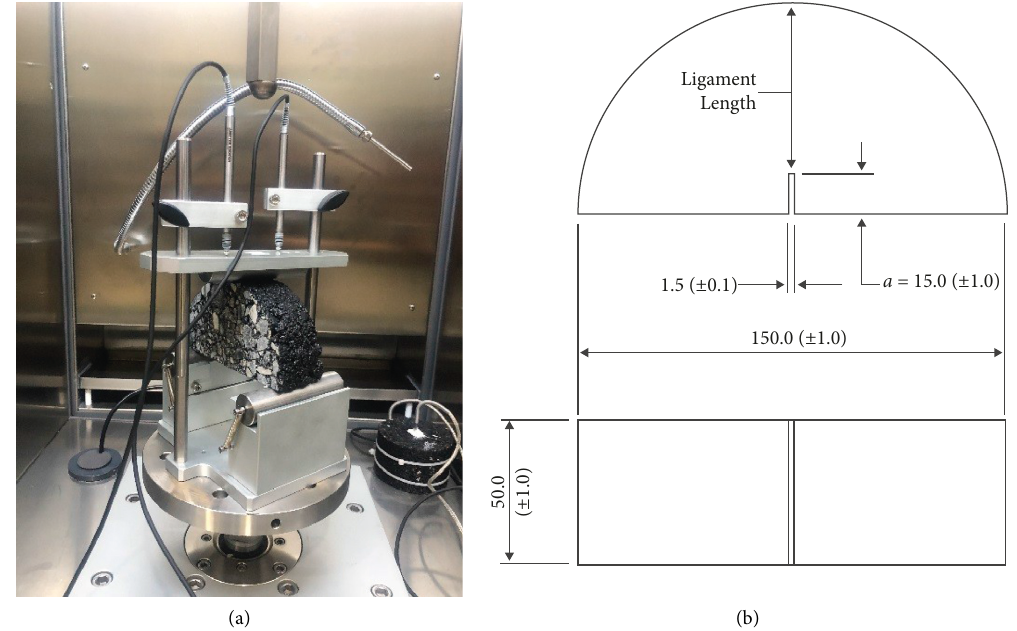
Figure 2: (a) SCB test fixture and (b) SCB test specimen configuration (dimensions in